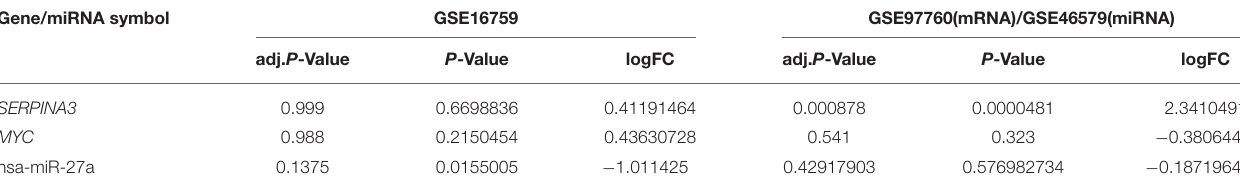
TABLE 11 | The expression the gene SERPINA3, hsa-miR-27a, and TF MYC from FFL in different datasets.